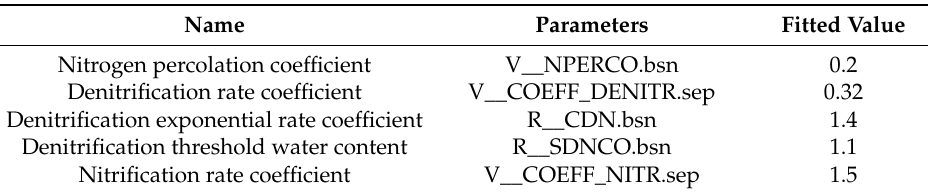
Table 5. Without OWTS input.